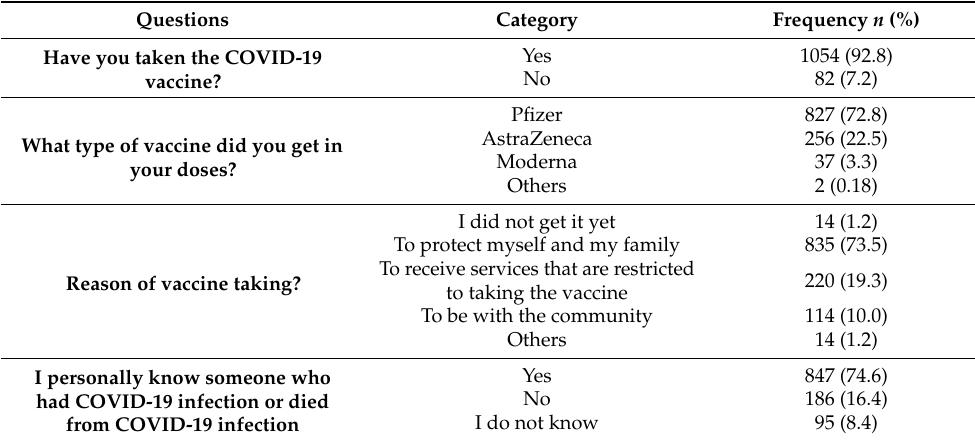
Table 2. Participants’ information about COVID-19 and its